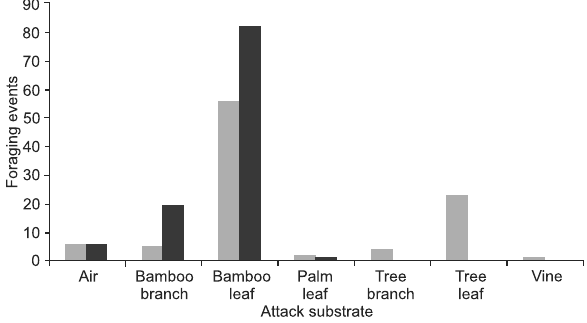
Figure 1. Attack substrates used by the Ramphotrigon fuscicauda (grey) and R. megacephalum (black) to capture the prey ( χ 2 = 41.185, df = 7, p <